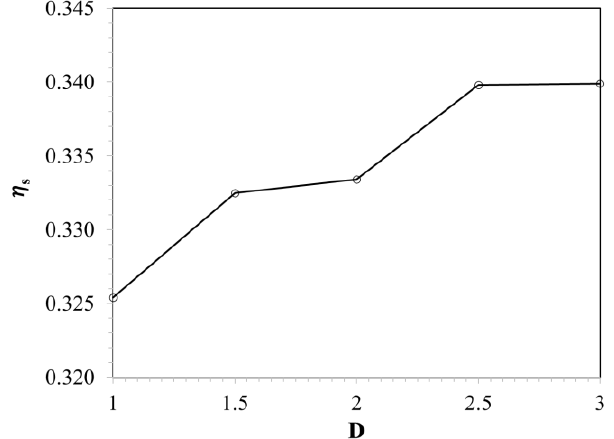
Figure 13. 𝜂 𝑠 with expansion to the sides of the inlet hole. Figure 13. η s with expansion to the sides of the inlet hole.